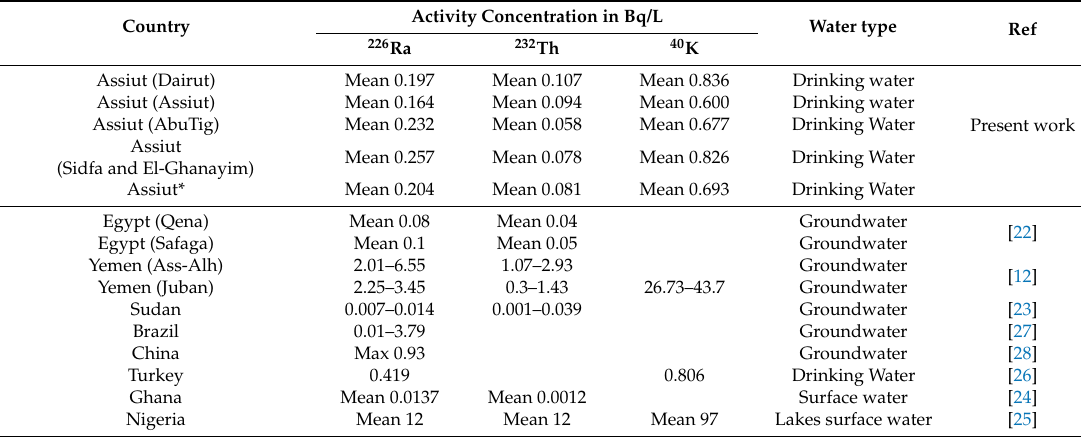
Table 6. The activity concentration in Bql − 1 of water samples in the present investigation in comparison with other